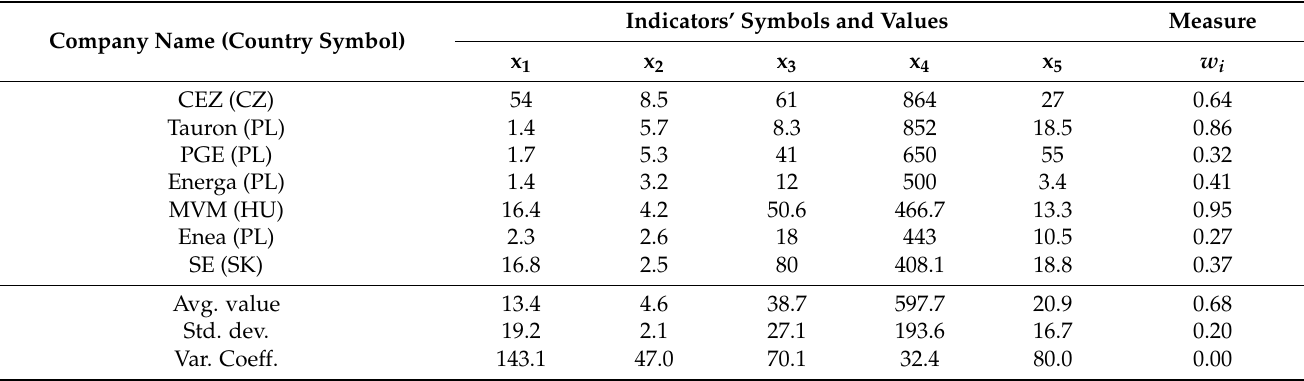
Table 3. Results for the V4 countries main energy producers.